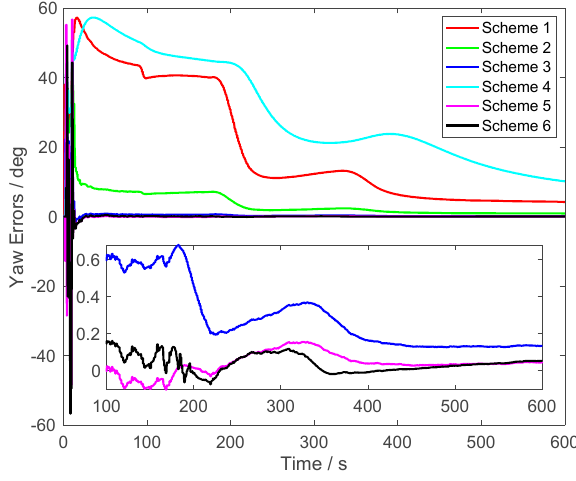
Figure 5. The yaw errors.